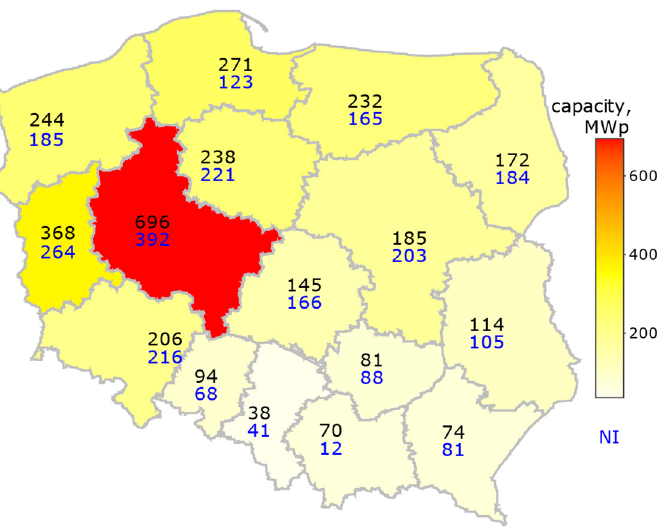
Figure 7. Capacity and number (NI) of PV installations created under the RES auction system in 2016–2020. Source: own study based on [36].